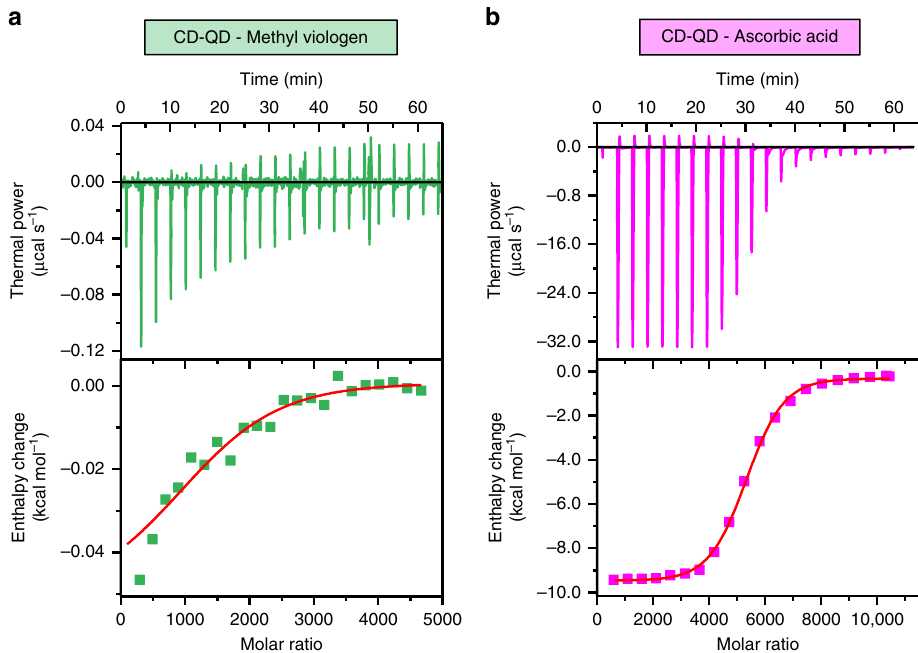
Fig. 5 Isothermal titration calorimetry (ITC) of β -cyclodextrin coated quantum dots (CD-QD) with chemical cargoes. Thermograms (top) showing the thermal power peaks corresponding to each chemical injection and binding isotherms (bottom) representing the enthalpy change determined by integrating thermal power pro fi les for CD-QD interacted with a methyl viologen and b ascorbic acid. The ITC results indicate that CD-QD exhibit a higher binding af fi nity to both methyl viologen and ascorbic acid than MPA-QD. Squares represent raw data and line represents best- fi t curves using a one-set-of- sites binding model.